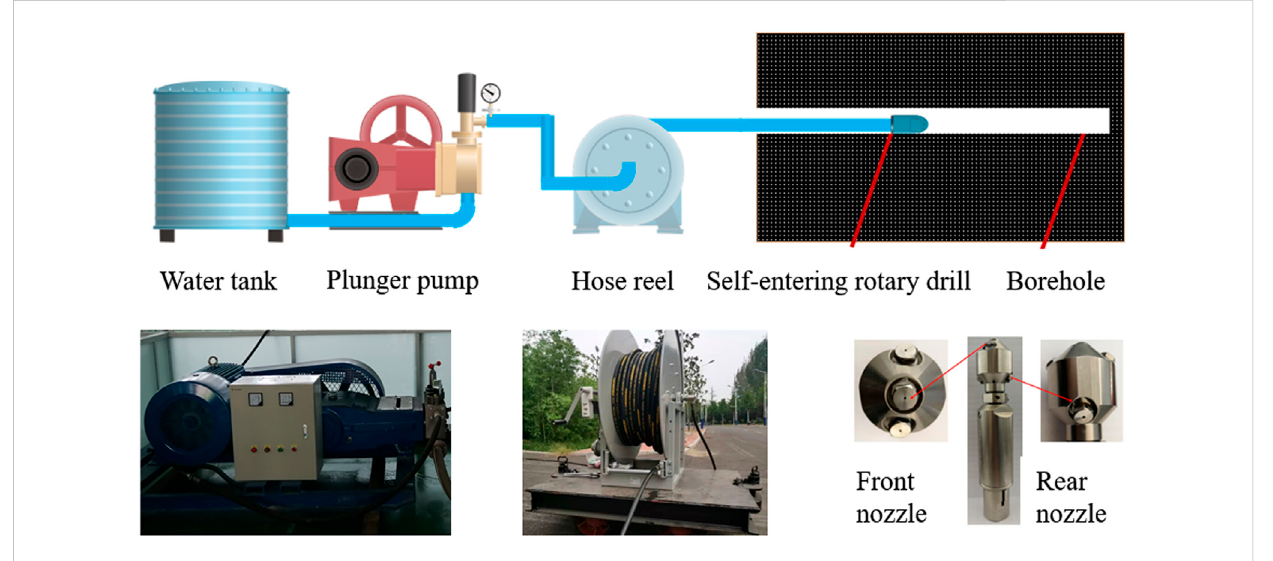
FIGURE 1 The self-propelling and rotating drill borehole restoration